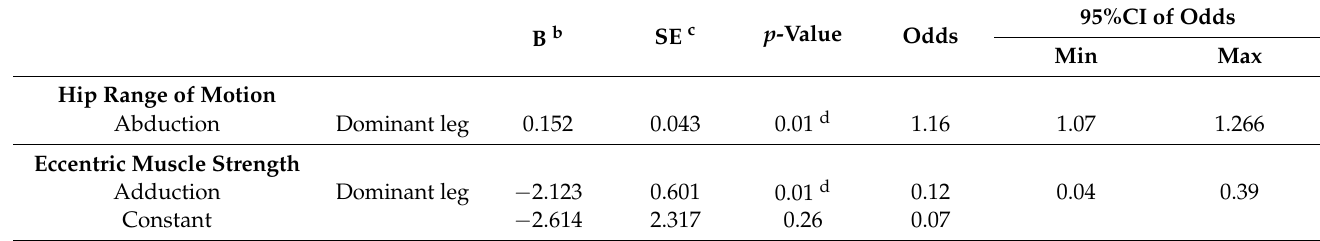
Table 6. Factors related to the development of groin pain (Multiple logistic regression analysis) a